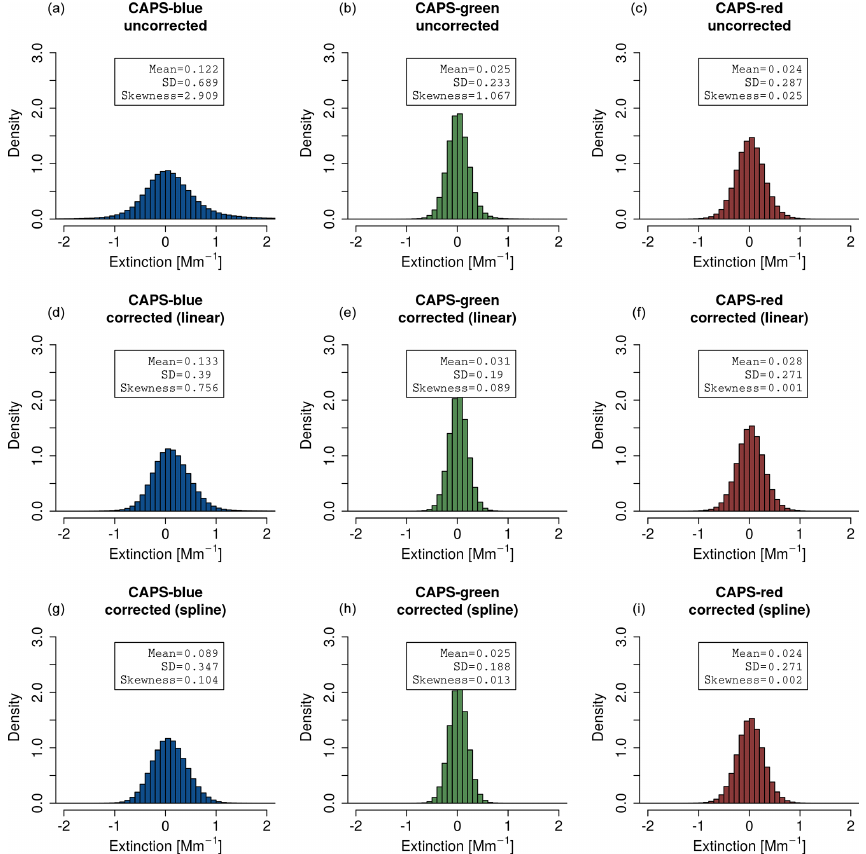
Figure 4. Histogram of the extinction values from measurements of particle-free ambient air for all three wavelengths (450, 530 and 630nm): (a) – (c) show the uncorrected extinction values, while (d) – (f) and (g) – (i) show corrected values using linear interpolation and cubic smoothing splines, respectively. The corresponding statistical parameters of the histograms are indicated in the